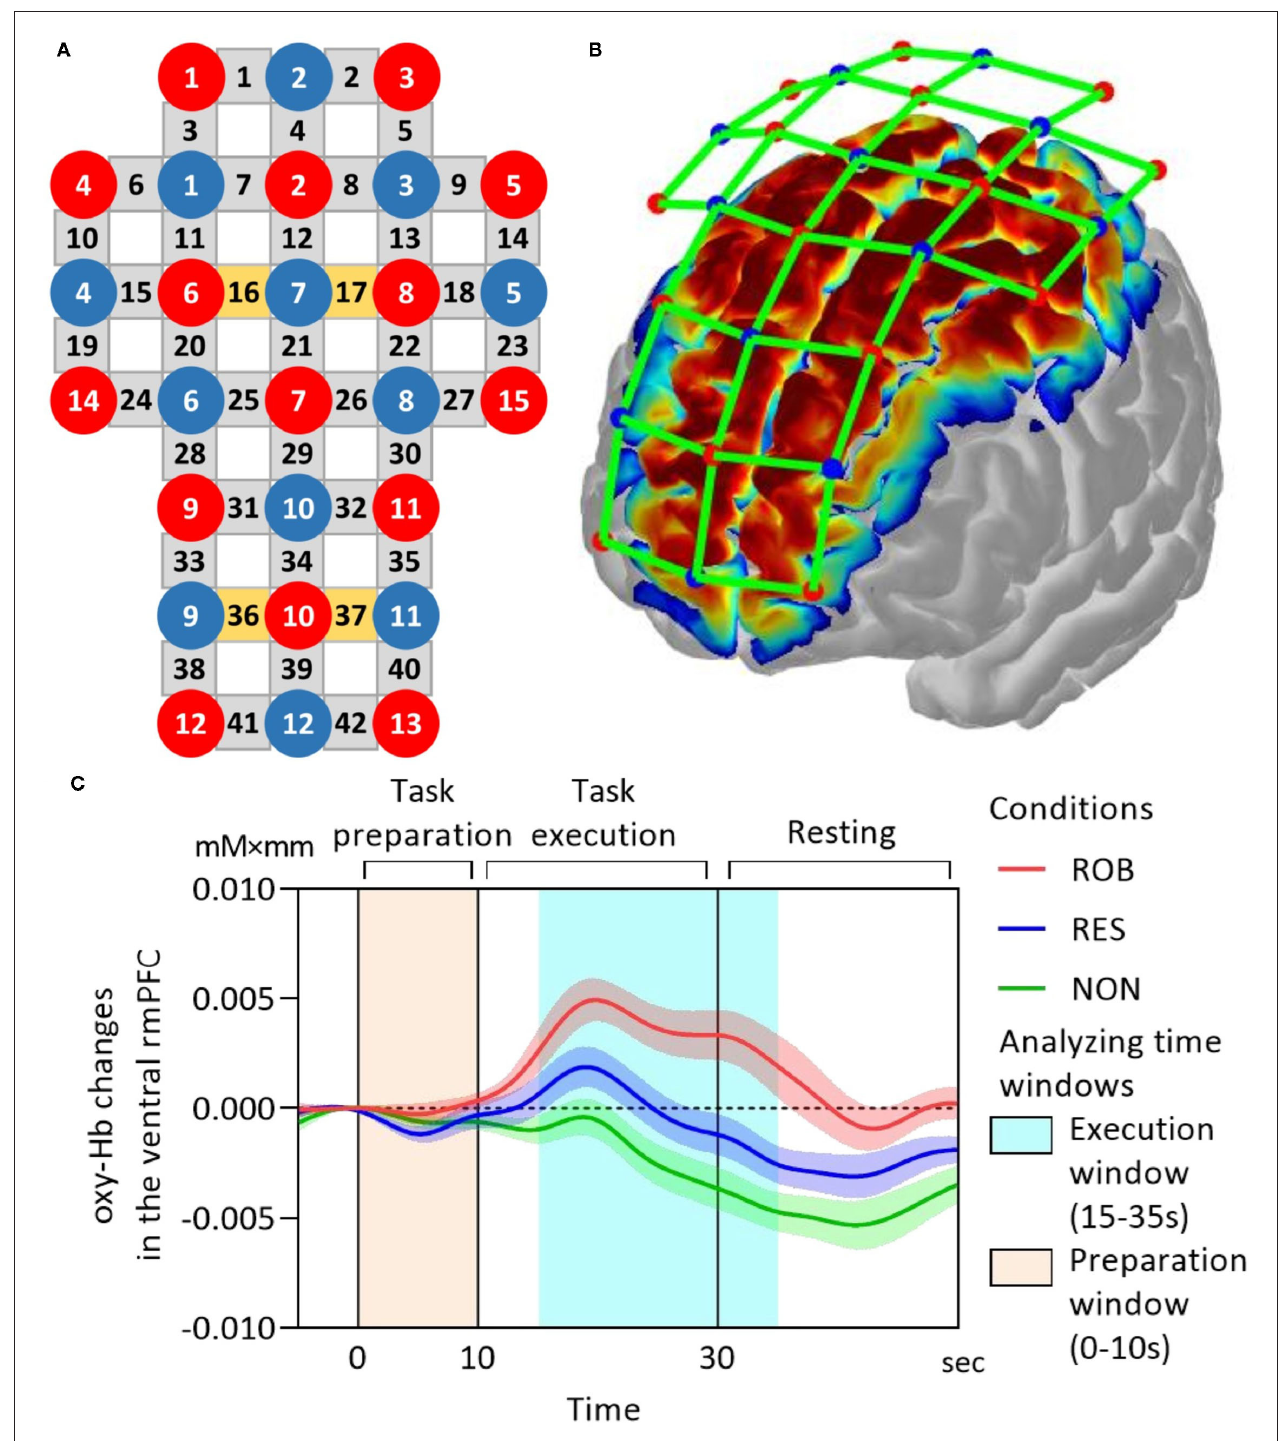
FIGURE 2 | fNIRS data acquisition. (A) fNIRS optode layout design. Red and blue-filled circles represent light sources and detectors, respectively. Yellow and gray rectangles represent long separation channels with and without short separation channels, respectively. The midline central point (Cz) is located underneath the 12th channel. The source-detector distance is 3cm. (B) The cortical mapping shows estimated spatial information of the measurement on the surface of the cerebral cortex using the current fNIRS optode configuration. (C) Grand-average oxy-Hb responses in the ventral rmPFC during ROB (red line), RES (blue line), and NON (green line). The task onset is at 0 on the x-axis. The time series were corrected to the baseline defined as the mean value over 2s before the onset. fNIRS, functional near-infrared spectroscopy; oxy-Hb, oxy-hemoglobin; rmPFC, rostromedial prefrontal cortex. Data are expressed as the mean with standard error (SE).